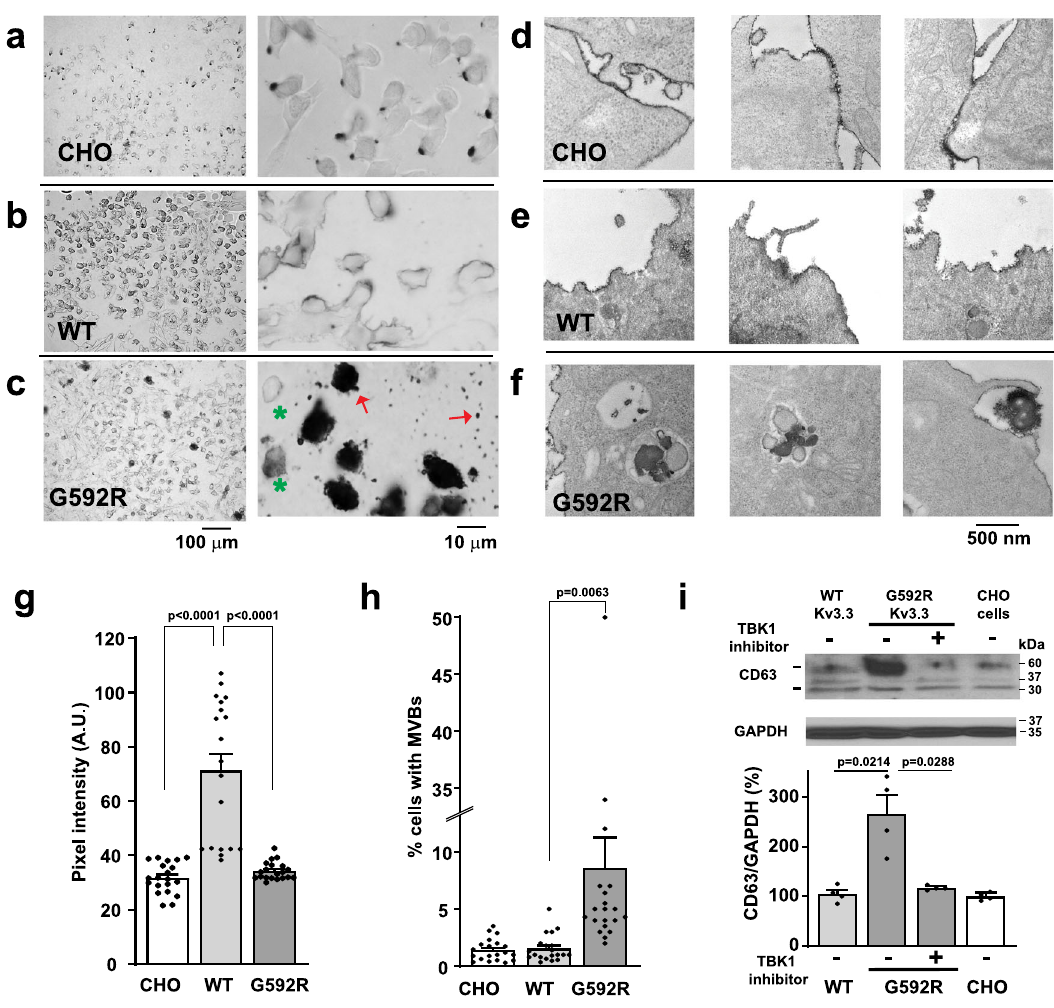
Fig. 5 The G592R Kv3.3 channel causes traf fi cking of Hax-1 into inclusions within lysosomes. Light level immunolocalization of Hax-1 in untransfected CHO cells ( a ) and cells expressing wild type ( b ) or G592R Kv3.3 ( c ). Left panels show low power views and right panels show Hax-1 immunostaining at higher magni fi cation. Scale bars under c apply to all pairs of panels in ( a – c ). In cells expressing G592R Kv3.3, the peripheral staining for Hax-1 resembles that of cells expressing the wild-type channel (green asterisks in right panel of e ). With the mutant channel, however, a high proportion of cells develop dense Hax-1 inclusions (multivesicular bodies), associated with extracellular deposits (red arrows in right panel of e ). Images are representative of 20 independent fi elds of cells. Electron immunolocalization of Hax-1 in untransfected CHO cells ( d ) and those expressing wild type ( e ) or G592R Kv3.3 ( f ). Hax-1 staining is found uniformly under the plasma membrane in cells expressing wild type Kv3.3. In G592R Kv3.3 cells, Hax-1 is localized not only to the plasma membrane but in large late endosomal/lysosomal structures. Panels are representative of 23, 20, and 87 images of untransfected CHO, wild-type Kv3.3 and G592R Kv3.3 cells, respectively. g Quanti fi cation of overall intensity of Hax-1 immunostaining in plates of untransfected CHO cells